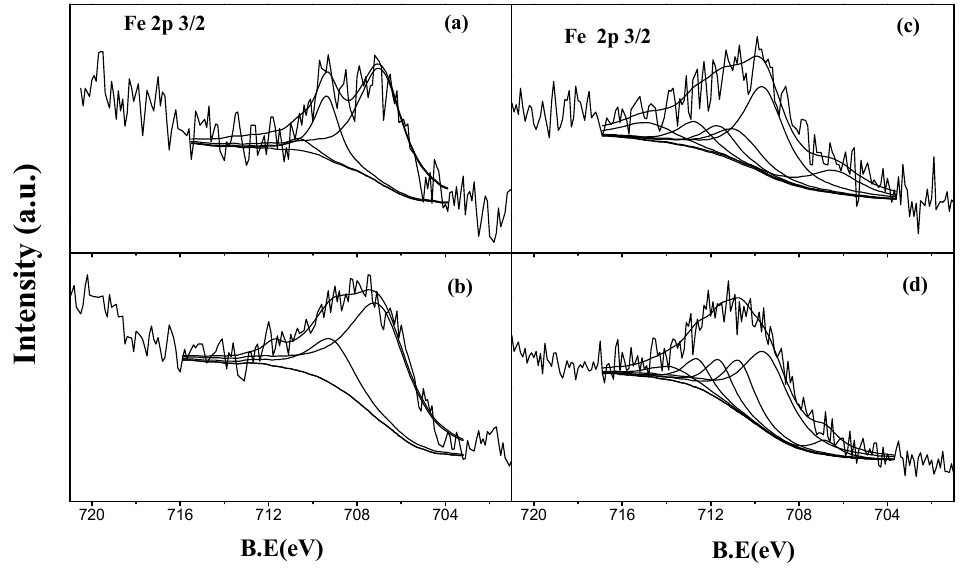
Figure 6. XPS of Fe 2p 3/2 in the reduced catalysts of ( a ) MNC 0.5 F 0.3 and ( b ) MNC 0.0 F 0.8 , and spent catalysts of ( c ) MNC 0.5 F 0.3 and ( d ) MNC 0.0 F 0.8 .